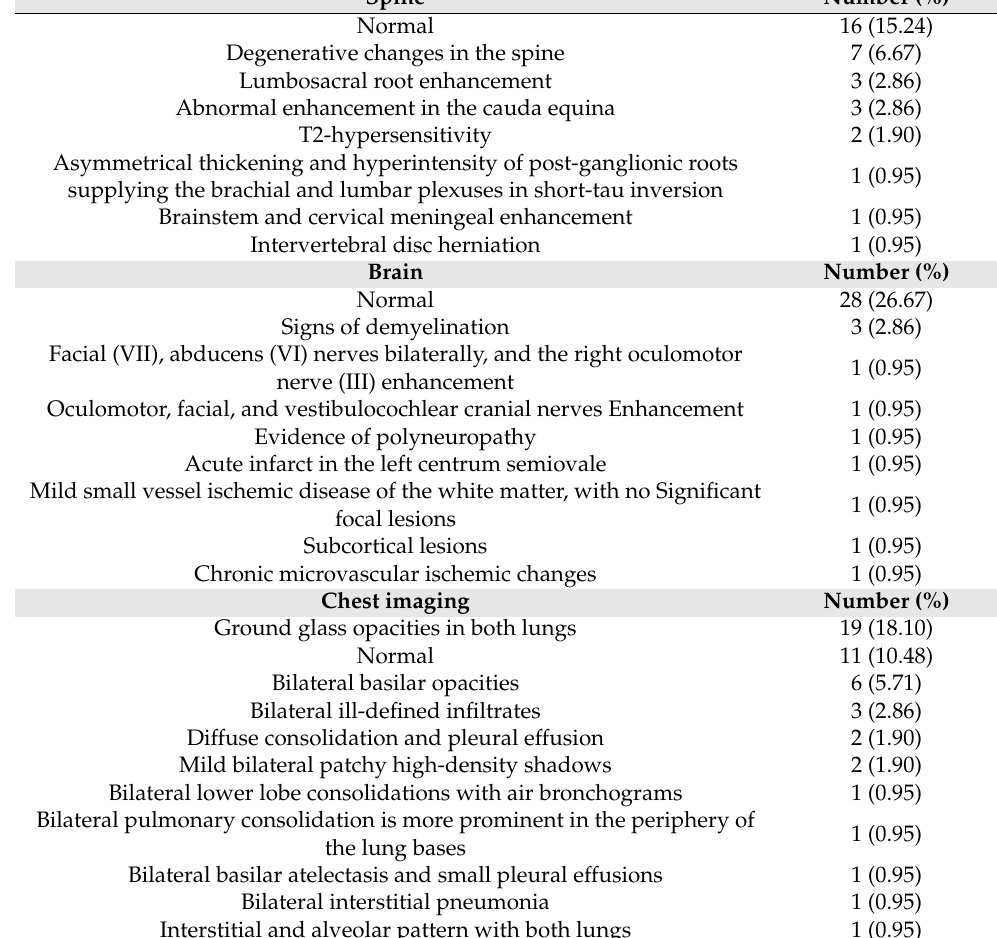
Table 8. MRI and CT